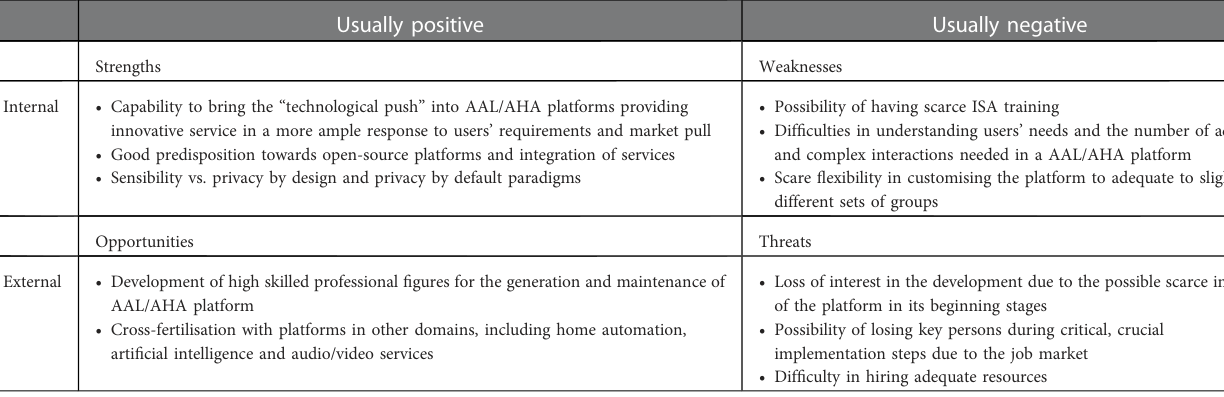
TABLE 4 SWOT for platform